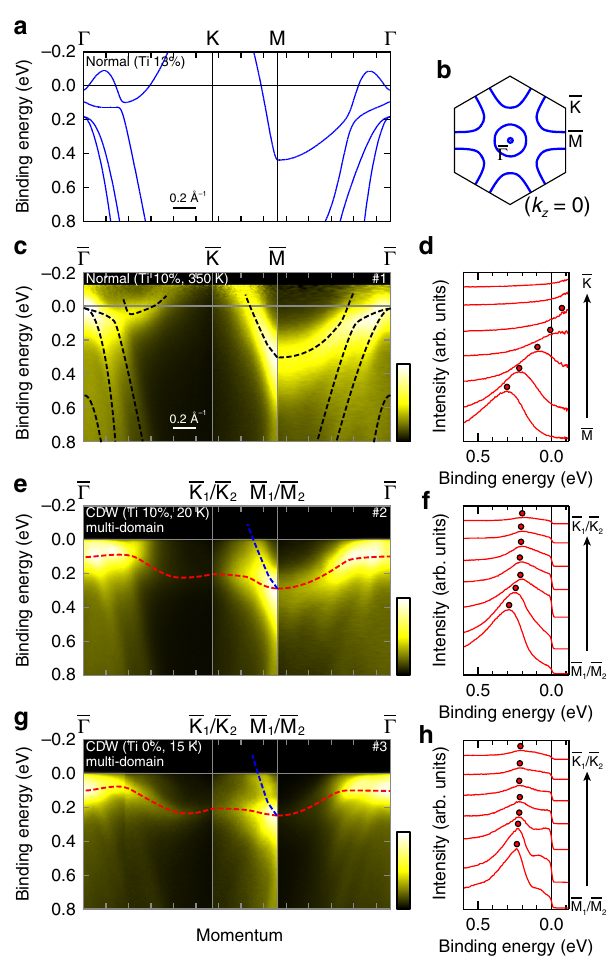
Fig. 3 Temperature/Ti-doping dependence of electronic structures. a The band calculation of V 0.87 Ti 0.13 Te 2 in the normal phase along the high symmetry line ( Γ -K-M- Γ ). b The corresponding Fermi surface in the k z = 0 plane. c ARPES image of V 0.90 Ti 0.10 Te 2 in the normal phase (350K, marked as #1 in Fig. 1f) recorded on the high symmetry lines. The data are divided by the Fermi- Dirac function convoluted with the Gaussian resolution function, to eliminate the thermal broadening of the Fermi cutoff. The broken black curves are the guide for the band dispersions, obtained by tracking the peaks of the energy and momentum distribution curves. d Energy distribution curves along the (cid:1) M (cid:1) (cid:1) K line for c (integral width: 0.05Å − 1 ). e ARPES image of V 0.90 Ti 0.10 Te 2 in the CDW phase (20K, #2) for the same momentum region as c . The red and blue curves indicate the fl at bands and dispersive band near the Fermi level, obtained in a similar manner with c . f Same as d , but for e (#2). g , h Same as e , f , but for the pristine VTe 2 in the CDW phase (15K, #3). All the ARPES data in the fi gure were obtained using a He-discharge lamp ( h ν = 21.2eV). The data in e – h include the signal from all the in-plane 120-degree CDW